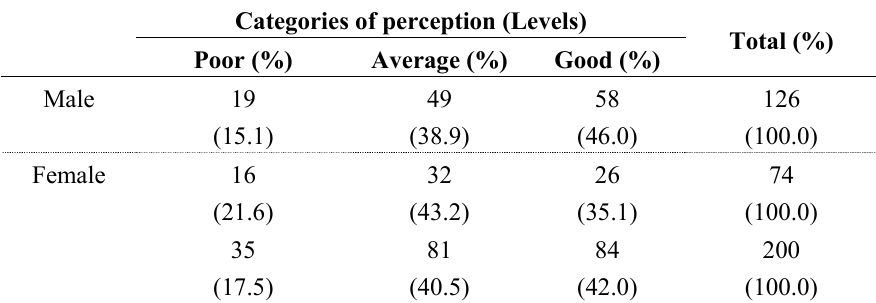
Table 2. Tourist’s perception levels on airport smoke-free policy by sex.